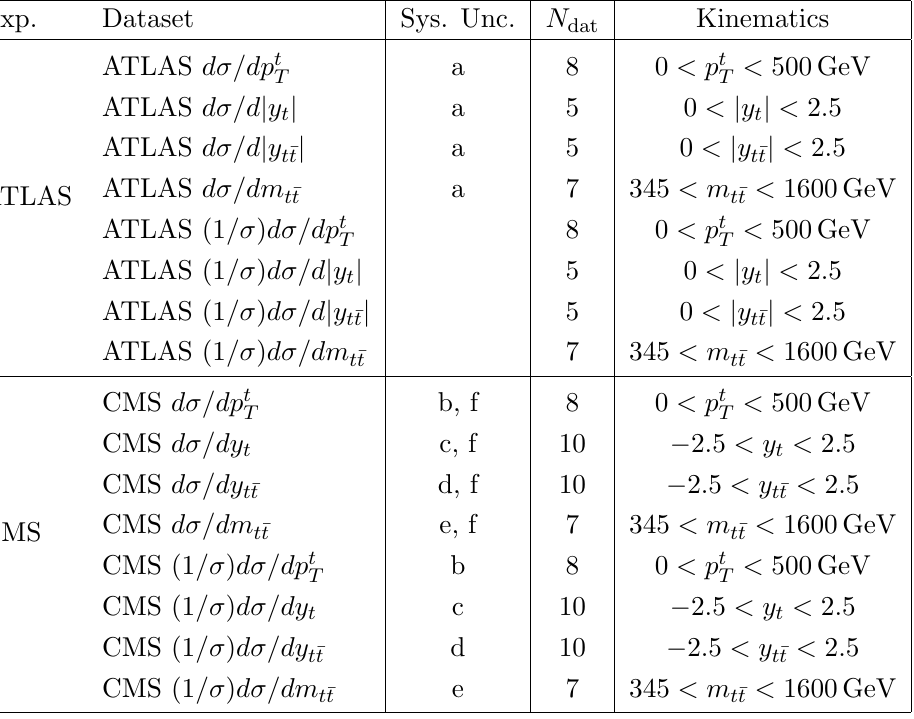
p s = 8 TeV used in this work. For